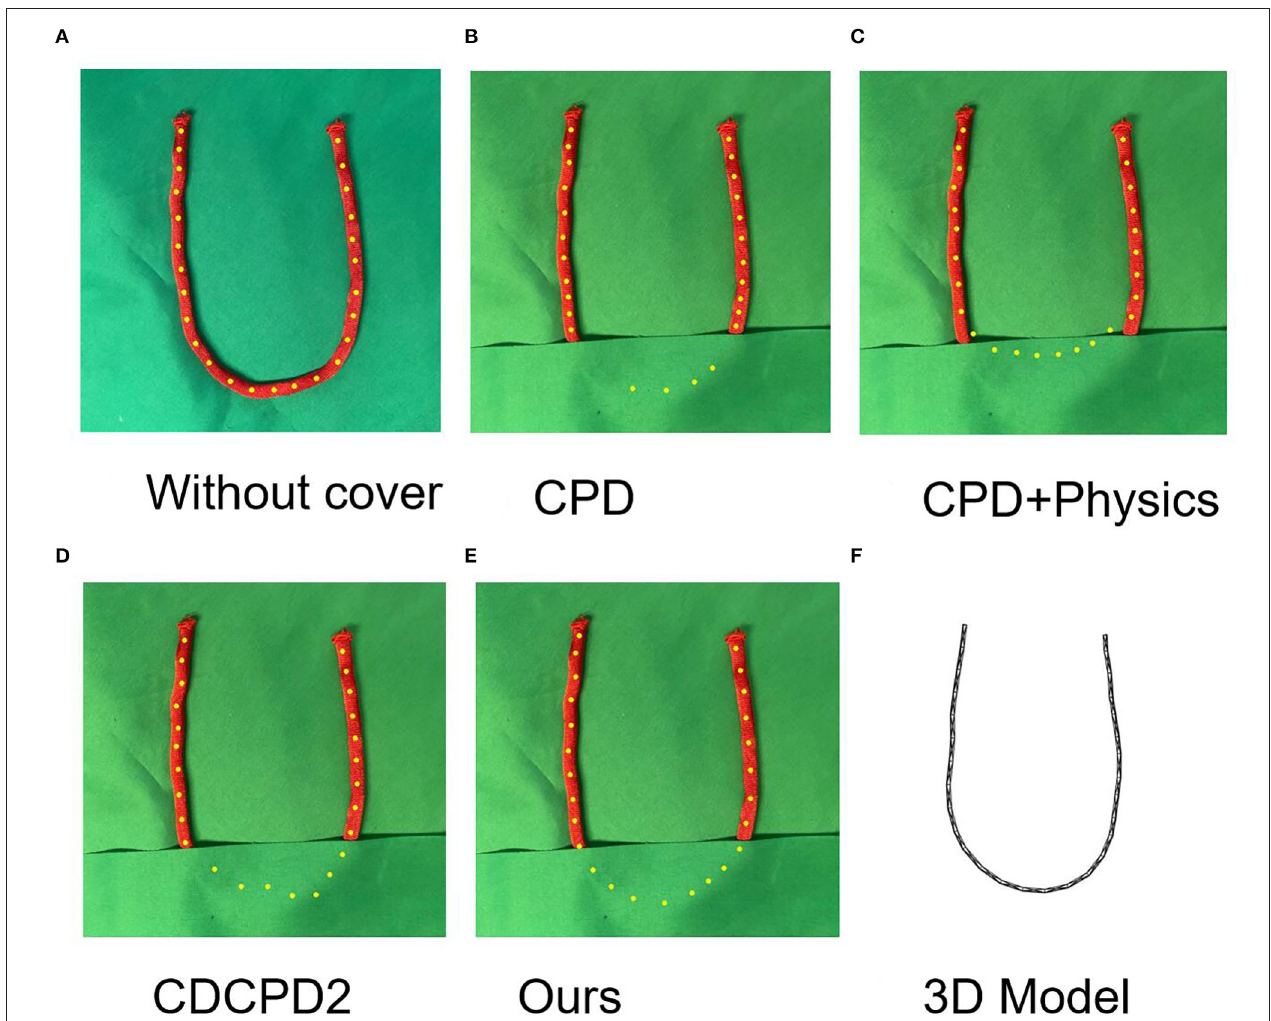
FIGURE 6 | The results of covering the U-shape rope for 10 seconds. (A) is registration result without cover. The yellow dots are registration results. (B–E) is the tracking results of CPD, CPD + Physics, CDCPD2, and our algorithm, respectively. (F) is the 3D model for our algorithm. Our algorithm is not sensitive to the occlusion time and can provide a stable result as time